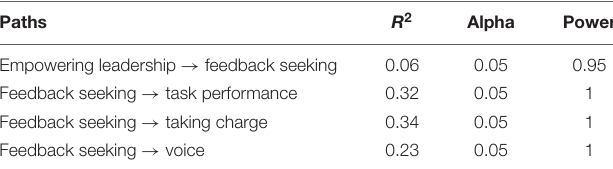
TABLE 5 | The statistical power of the paths in the hypothesized model.